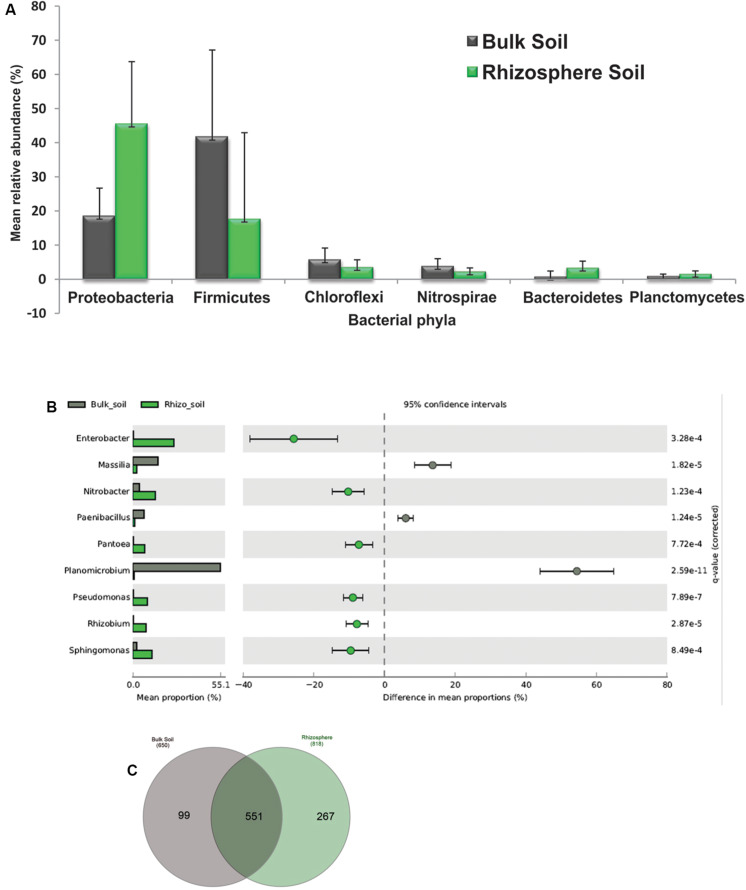
Differentially abundant bacterial taxa across the bulk soil and pea rhizosphere samples. (A) At the phylum level. (B) At the genera level. (C) Venn diagram representing the number of shared and unique OTUs in the bulk soil and rhizosphere soil samples.